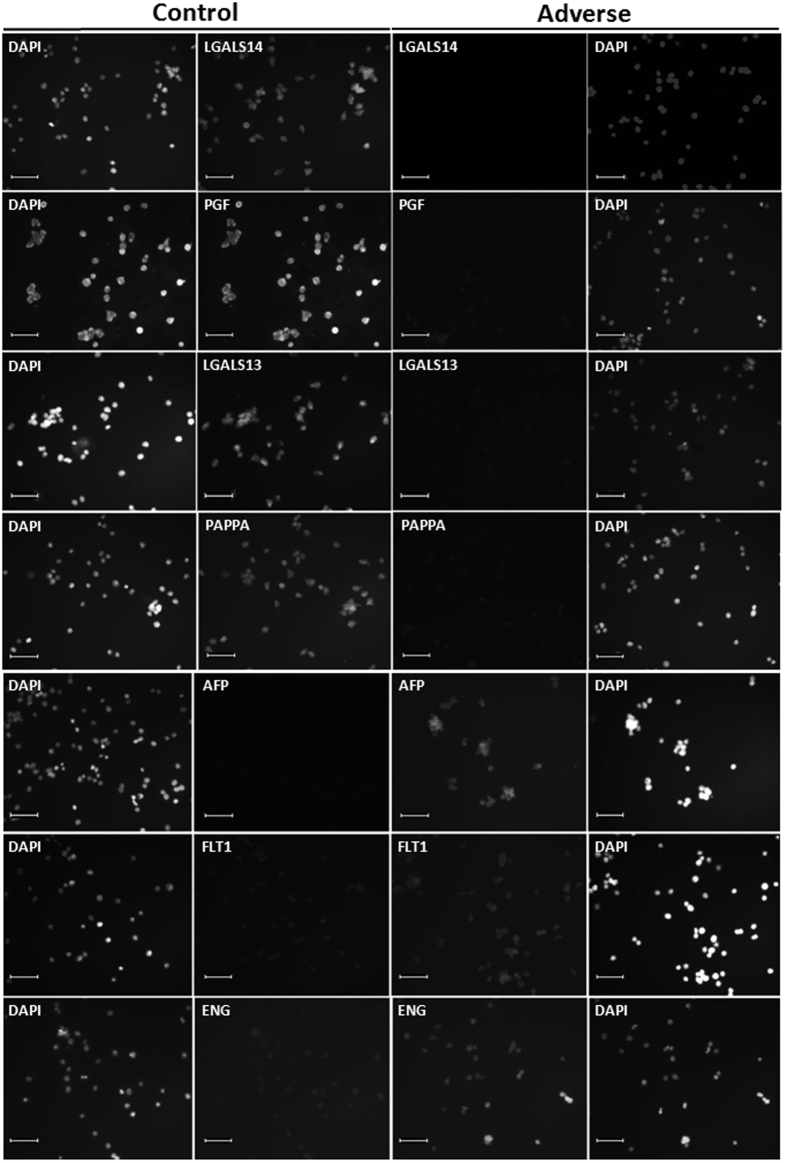
Representative fluorescence microscopic images of EVT cells obtained by TRIC from Control and Adverse pregnancies.Paired images are shown for fields of cells labeled with DAPI or by immunofluorescence for the proteins, as indicated. Size bars, 100 μm.